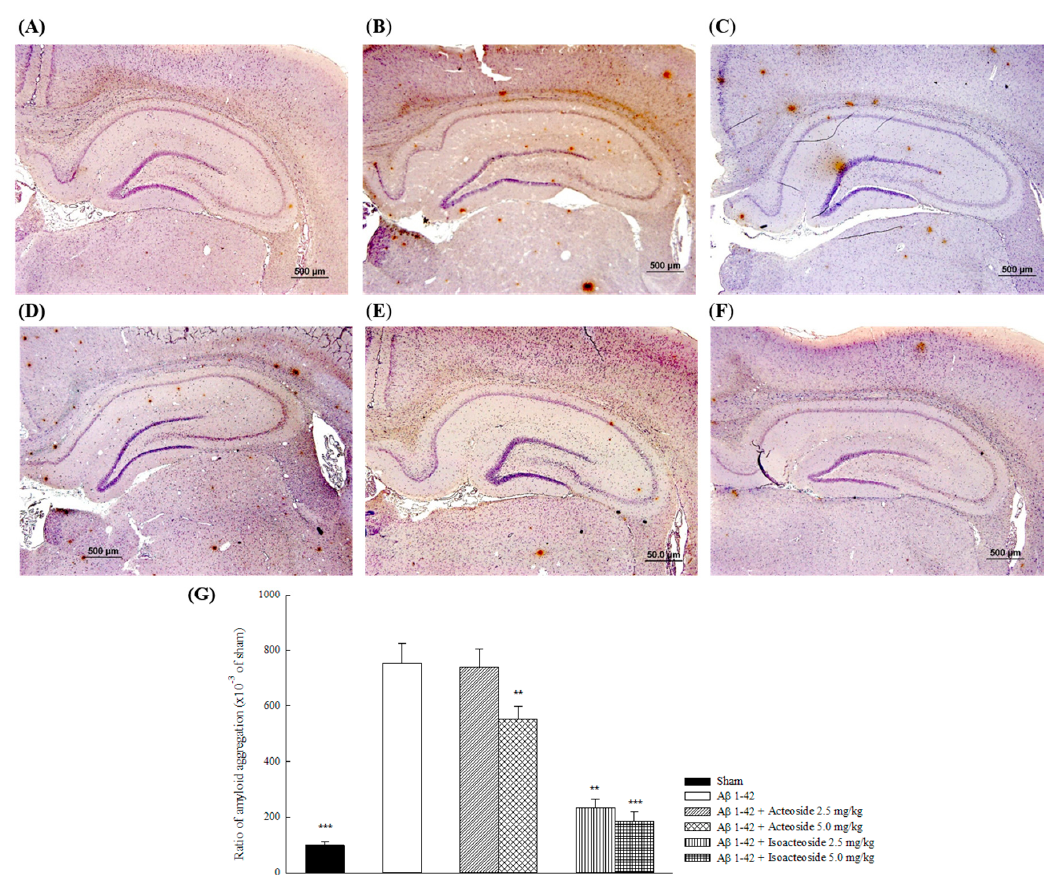
Figure 4. Effects of acteoside or isoacteoside (2.5, 5.0 mg/kg; po) on A β 1-42 deposition in A β 1-42-